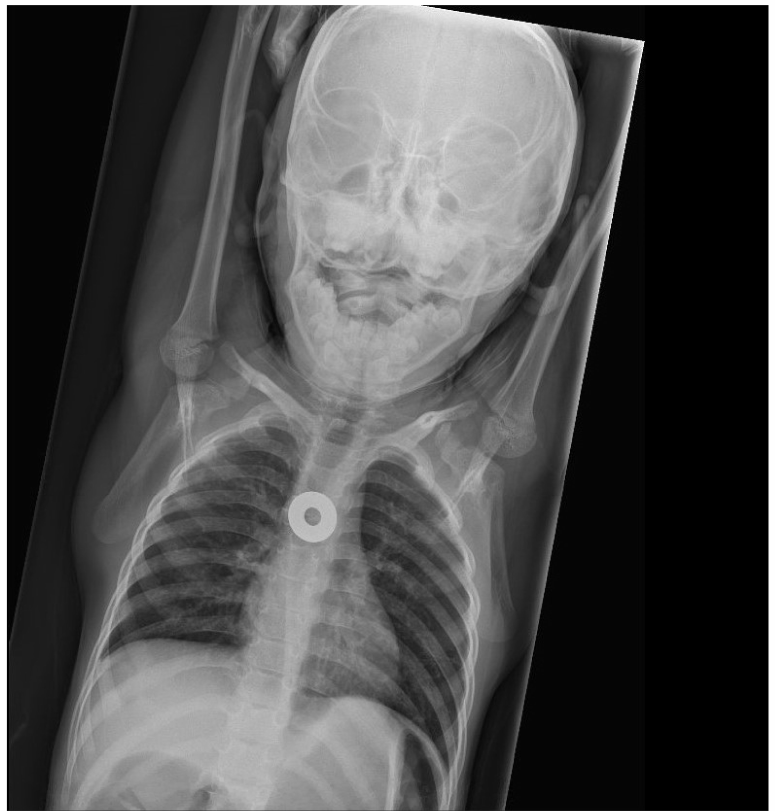
Figure 2. Chest radiograph showing swallowed hardware (washer) lodged in the mid-esophagus.